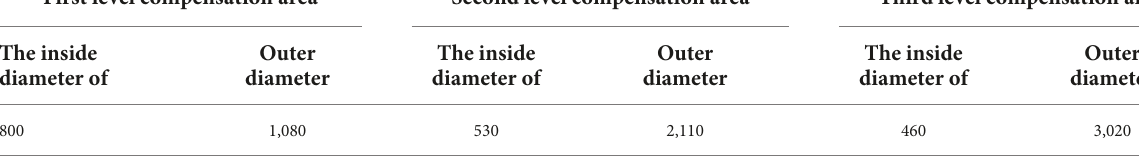
TABLE 18 Compensation area division in the W direction.